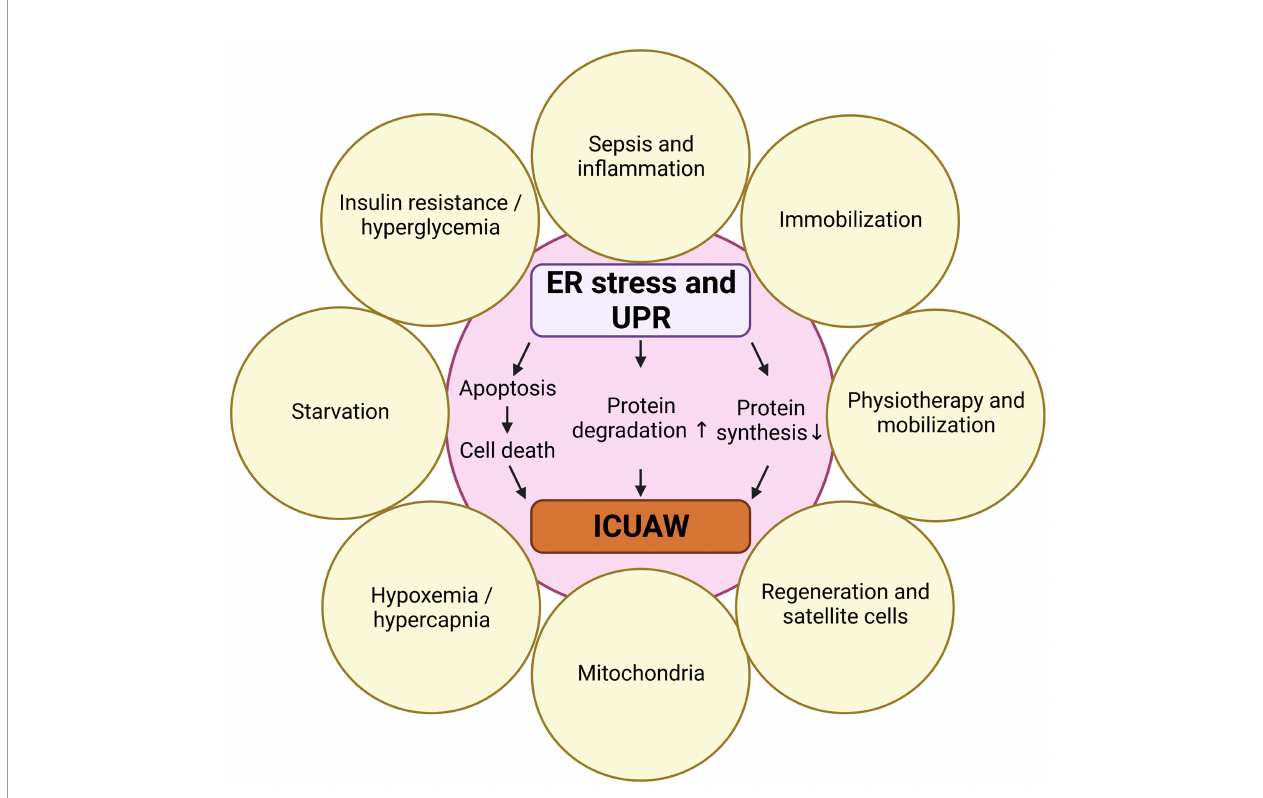
FIGURE 1 | Risk factors for ICUAW that are also involved in ER stress and UPR. Created with